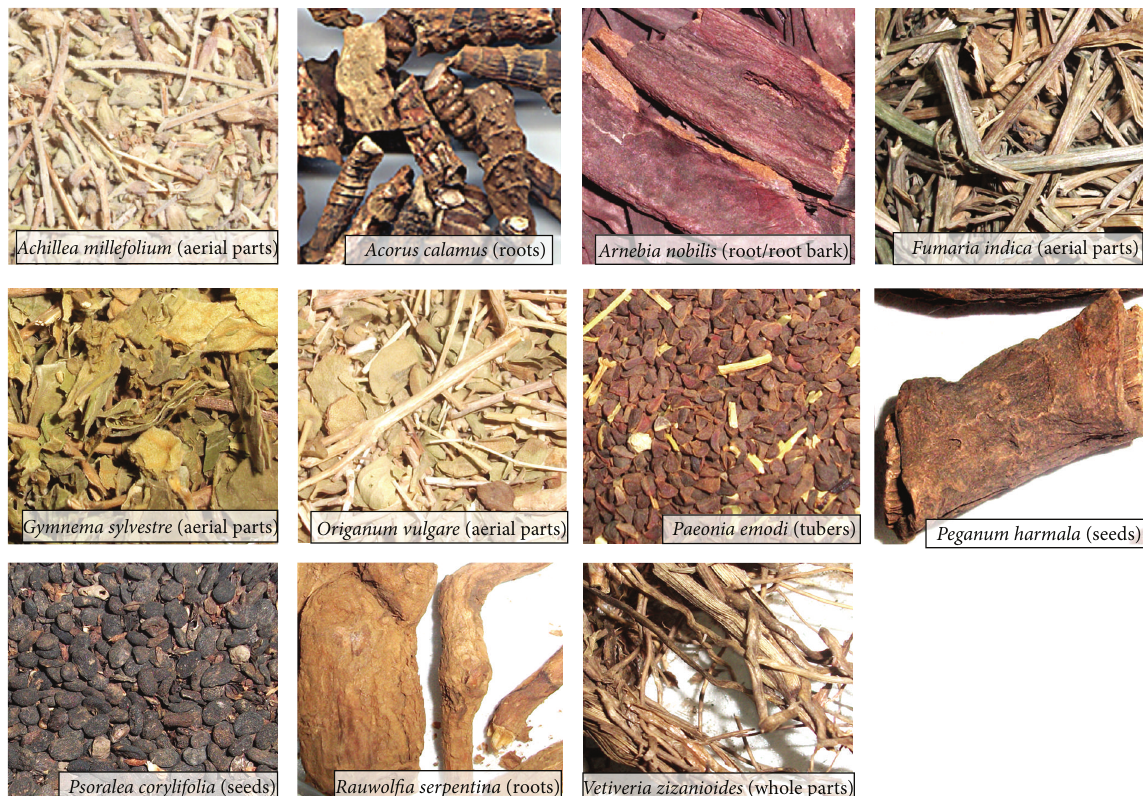
Figure 2: Different parts of high valued medicinal plants used in different herbal formulations. Aerial parts of Achillea millefolium , roots of Acorus calmus , roots of Arnebia nobilis , aerial parts of Fumaria indica , aerial parts of Gymnema sylvestre , aerial parts of Poeonia emodi , seeds of Peganum harmala , seeds of Psoralea corylifolia , roots of Rauvolfia serpentine and whole parts of Vetiveria zizanoides